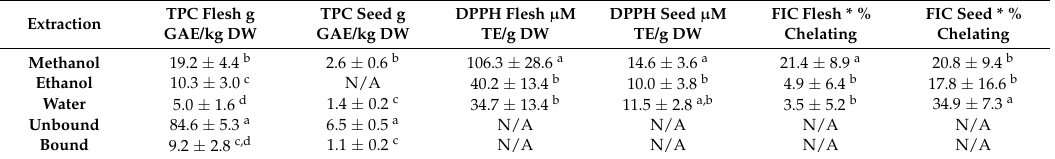
Table 1. In vitro antioxidant capacity of green plum flesh and seed freeze dried powders.